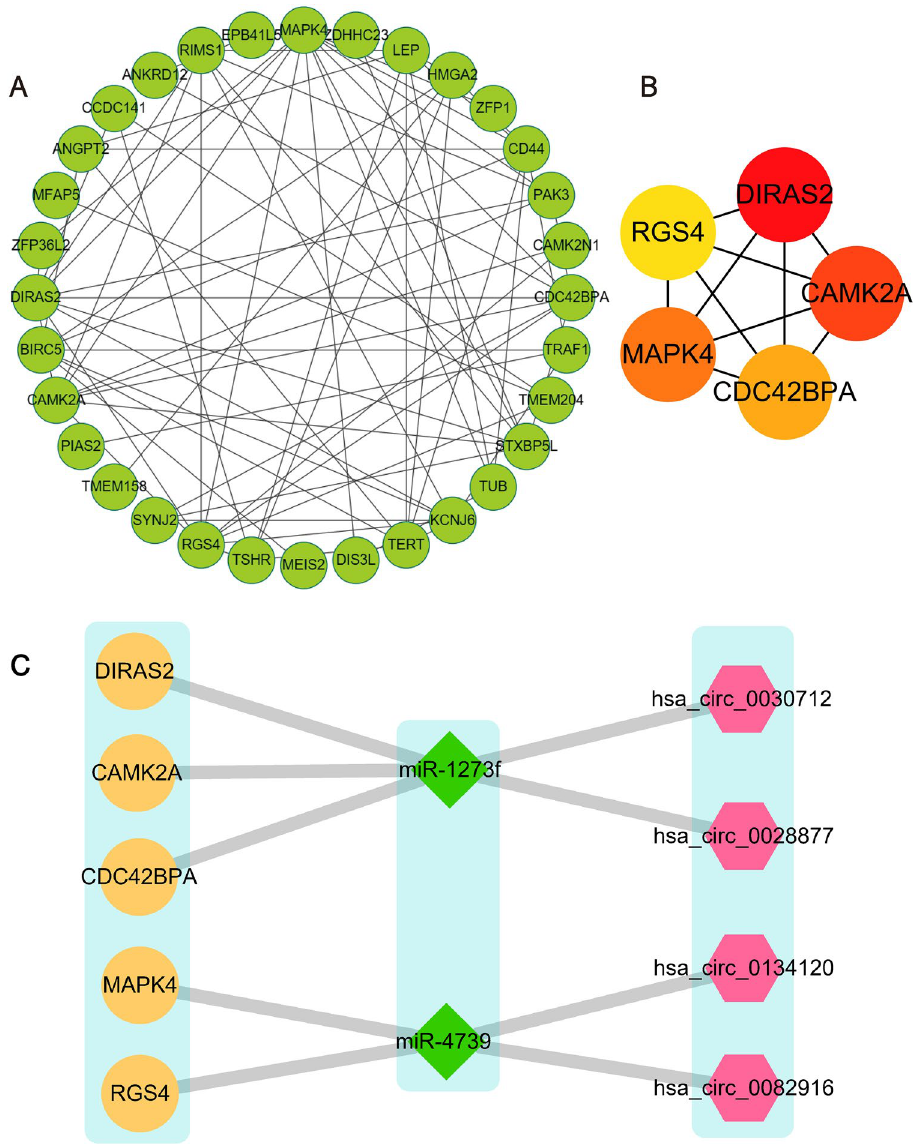
Figure 8. PPI network establishment and hub genes identification of the target genes. ( A ) PPI network of the target genes. ( B ) Identification of 5 hub genes from the PPI network with the Cytohubba algorithm. ( C ) CircRNA–miRNA–hub gene subnetwork. PPI protein–protein